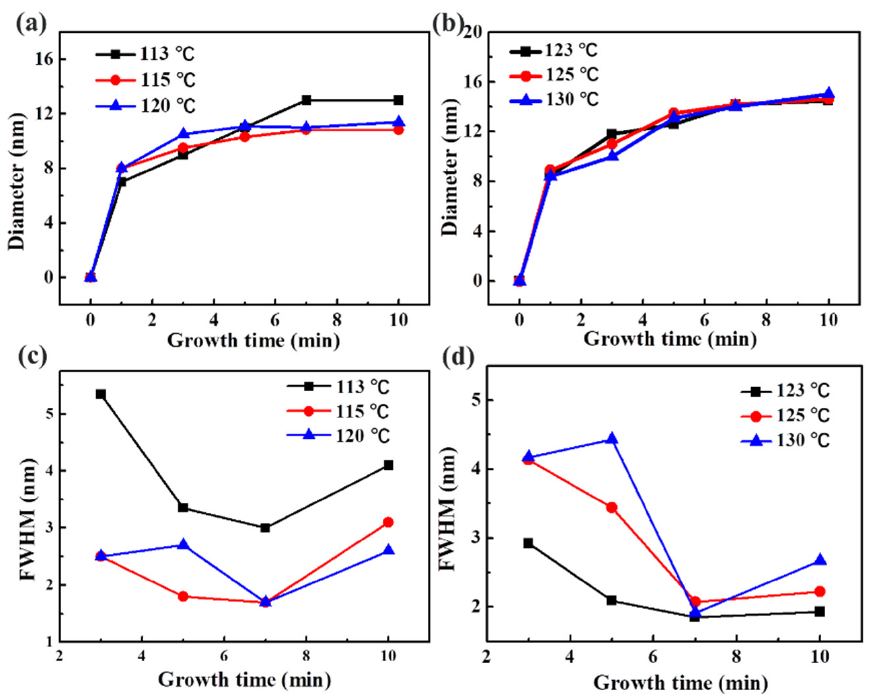
Figure 2. When the injection temperature is 120 °C ( a ) and 130 °C ( b ), the relationship between particle size and growth time at different growth temperatures; when the injection temperature is 120 °C ( c ) and 130 °C ( d ), the relationship between FWHM and growth time at different growth